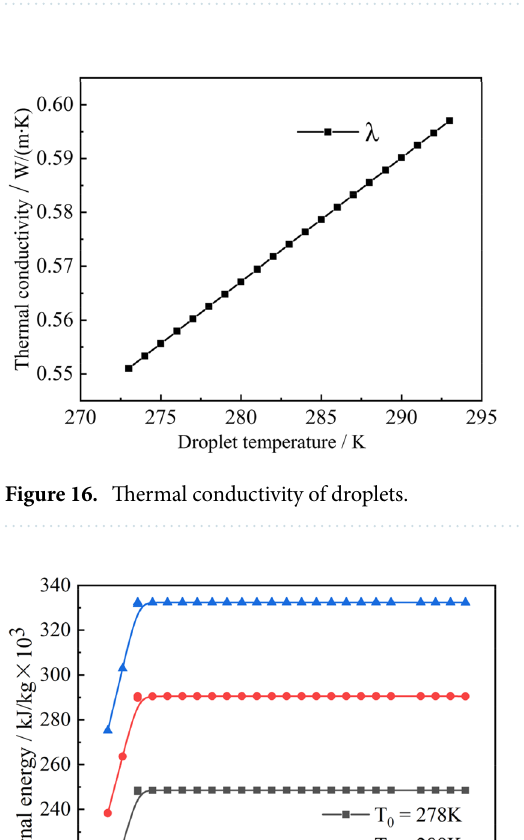
Figure 15. Time to phase transition point.